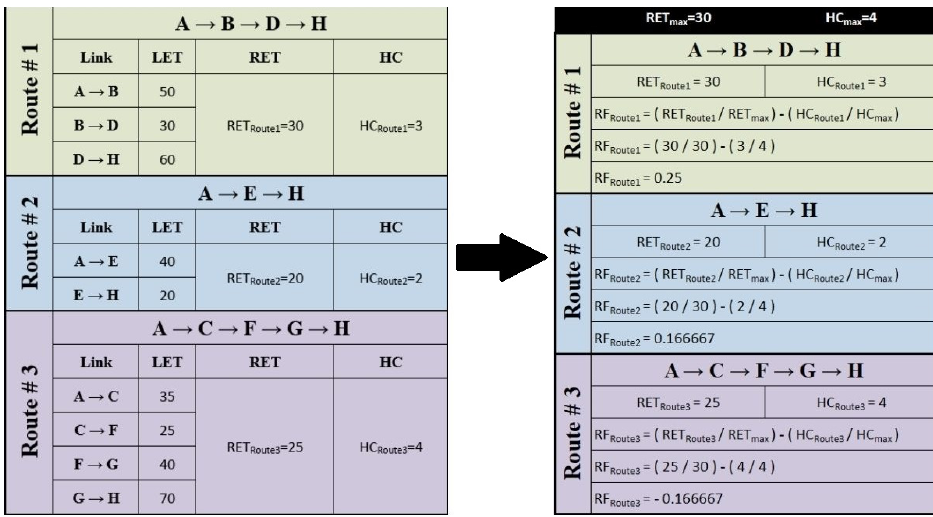
Figure 7. Tabular explanation and calculation of the best possible Reliability Factor (RF)